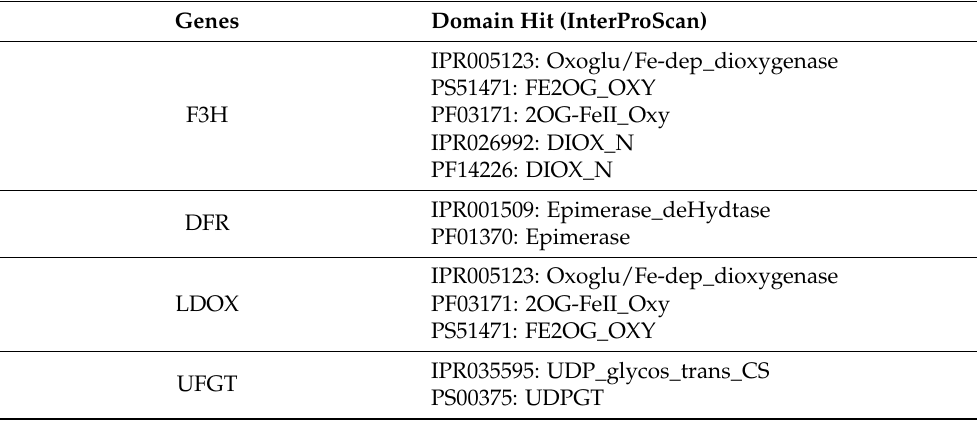
Table 3. The domain prediction for four key genes in the anthocyanin biosynthetic pathway (F3H, DFR, LDOX, and UFGT) identified from C. caudatus transcript against InterProScan